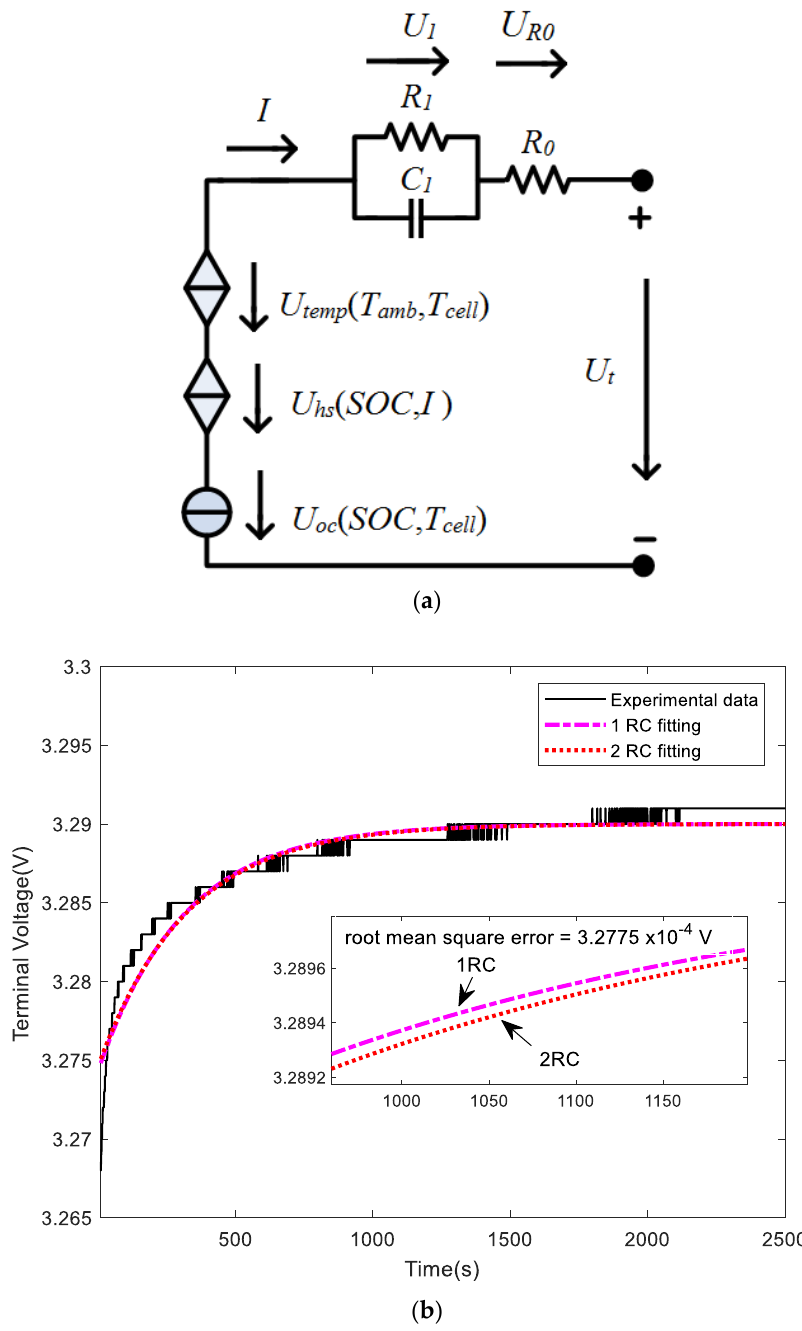
Figure 1. ( a ) Proposed ambient and cell temperature-dependent ECM of battery cell; ( b ) terminal voltage of 1RC and 2RC as compared to experiment data.